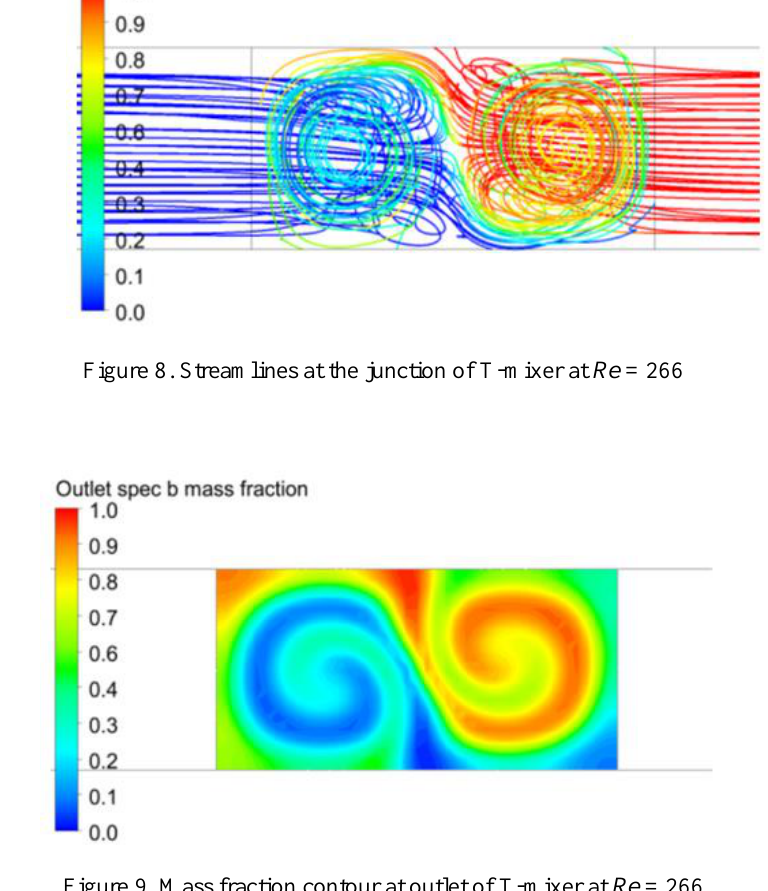
Figure 9. Mass fraction contour at outlet of T-mixer at Re =